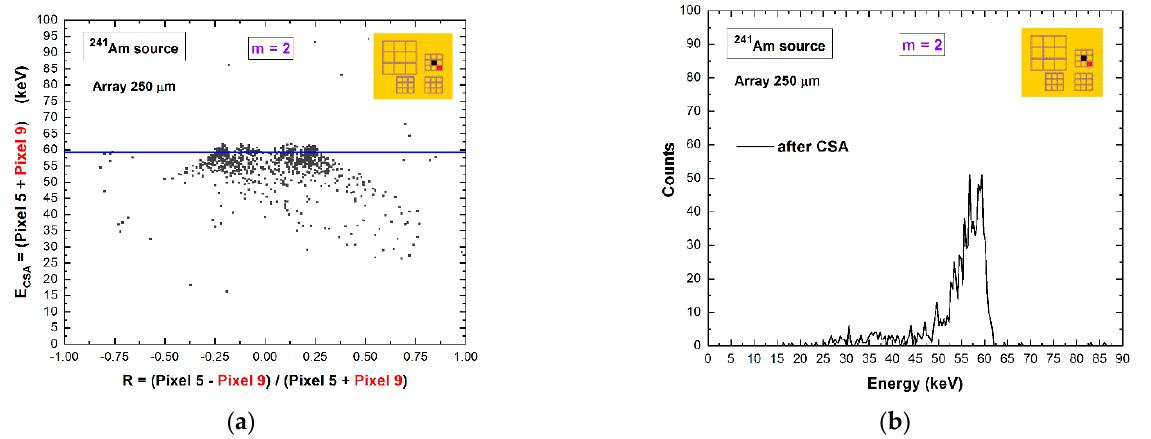
Figure 9. ( a ) Two-dimensional (2D) scatter plot of the summed energy of the coincidence events ( m = 2) between diagonal pixels (no. 5 and pixel no. 9), after CSA, versus the ratio R . ( b ) The energy spectrum shows the absence of charge losses after CSA, demonstrating that the double coincidence events between diagonal pixels are mainly due to the fluorescent/escape events.